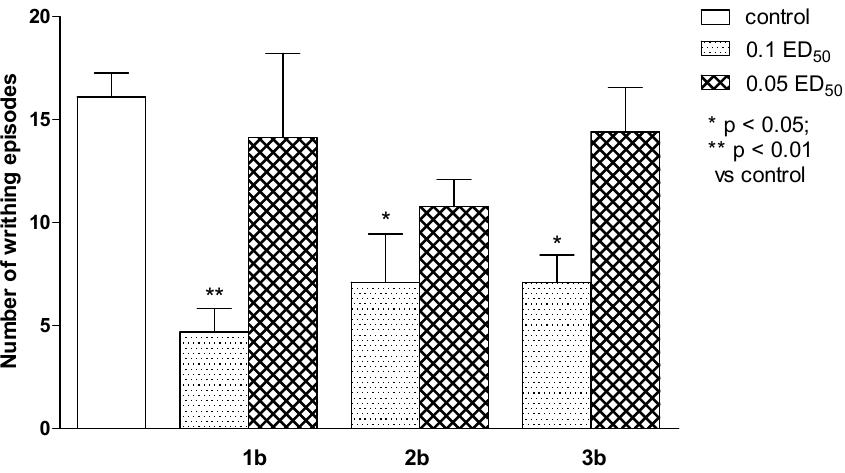
Figure 4. The antinociceptive effects of 1b , 2b and 3b assessed in the ‘writhing’ test in mice. One-way ANOVA showed significant changes in the number of writhing episodes of mice after the administration of compounds 1b, 2b and 3b (F = 4.725, p < 0.001). Post 6.58 hoc Dunnett’s test confirmed a significant reduction in the writhing episodes of mice after the administration of the compound 1b in the dose of 0.1 ED ( p < 0.01) and compounds 50 2b and 3b in the dose of 0.1 ED ( p < 0.05). 50